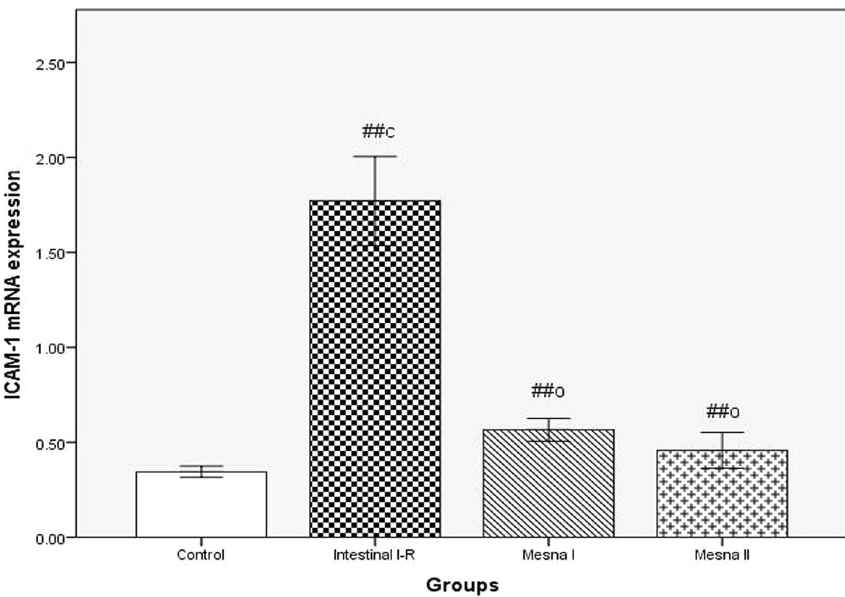
Figure 1. RT-PCR analysis of lungs’ ICAM-1 mRNA expression estimated as ICAM-1/GAPDH ratio. Expression of values is as mean ± standard error (X ± SE); n = 10 animals; c : P comparable to control group; o : P comparable to intestinal I–R group; # : P < 0.05; ## : P <